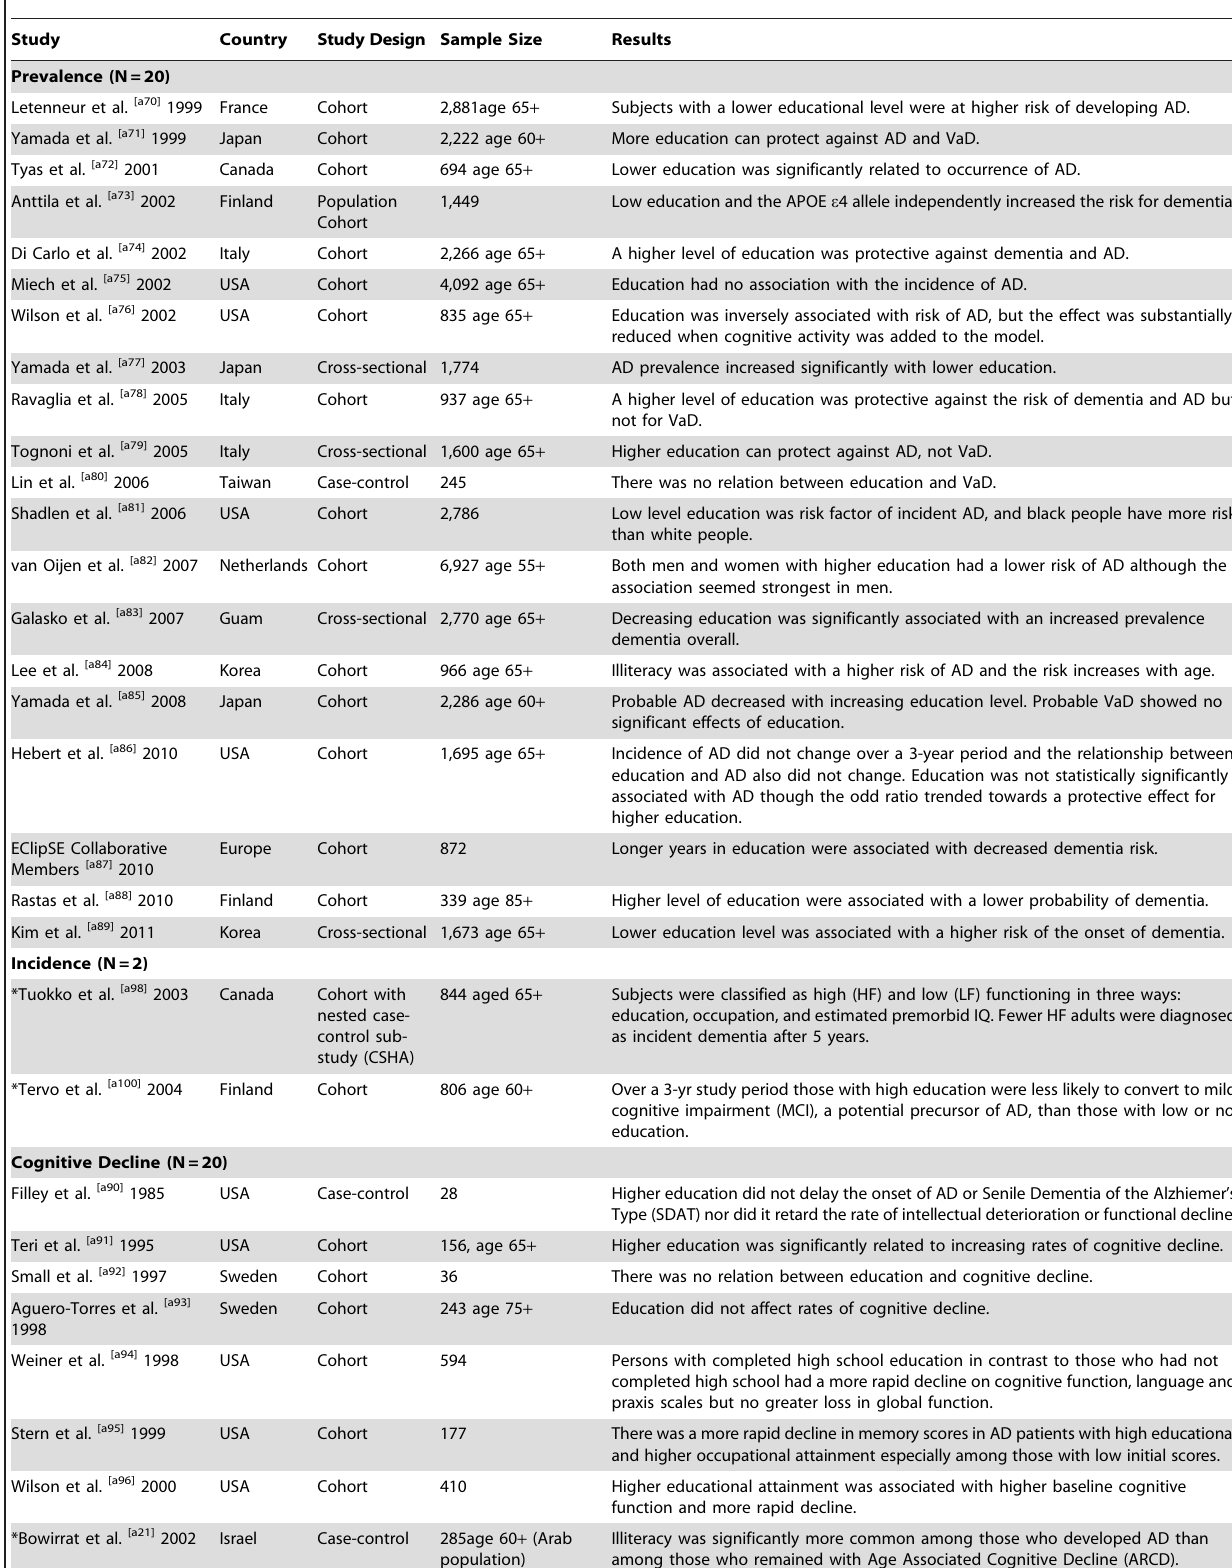
Table 2. Qualitative analysis: Studies linking education to various aspects of dementia (* denotes studies with findings related to two or more areas of